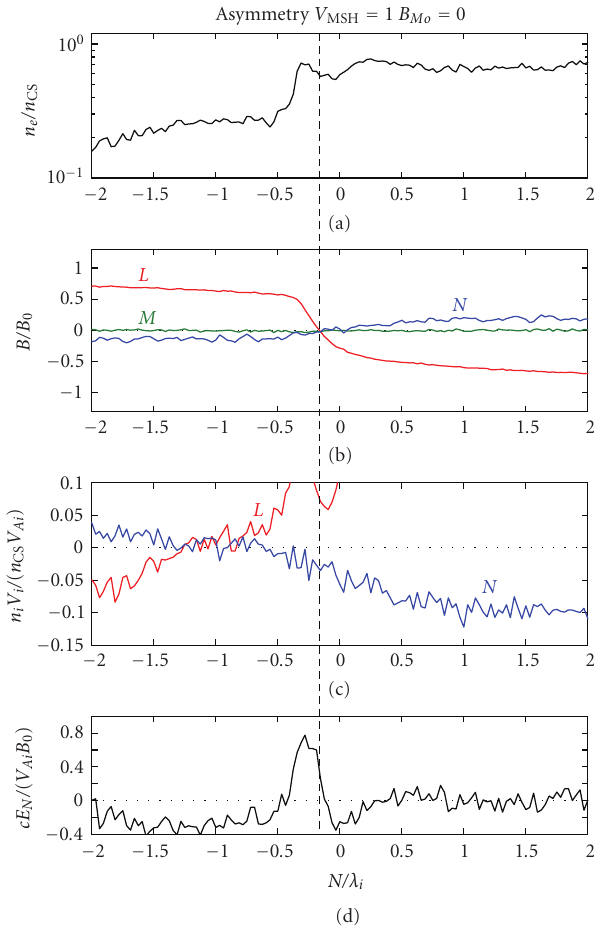
Figure 8: Various parameters along the red arrow shown in Figure 7. In the same format as Figure 5, Panel (c) clearly indicates that the ion flow component at the X-line V iL,XL is nonzero and positive.